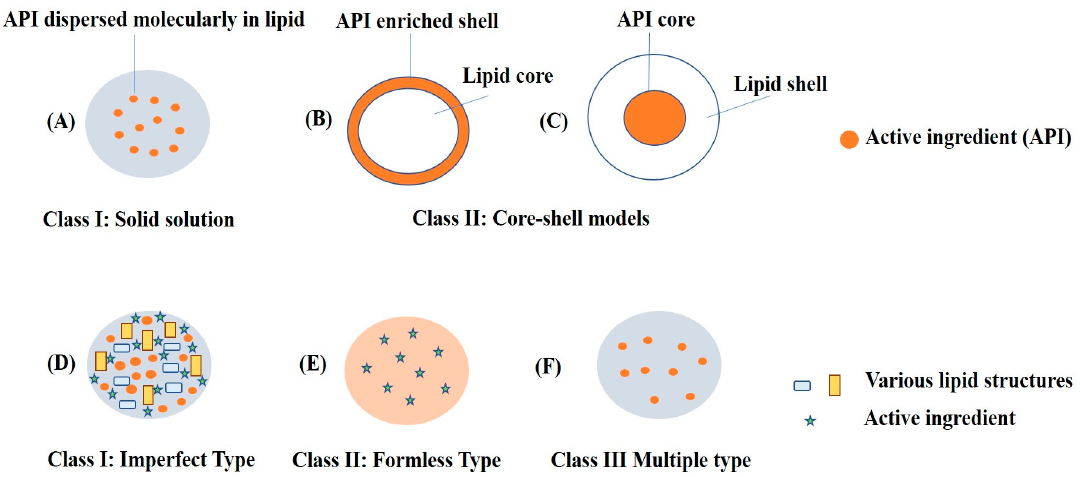
Figure 3. Schematic representation of SLNs: ( A ) solid solution model; ( B ) core-shell model (drug- enriched shell); and ( C ) core-shell model (lipid-enriched shell) and NLCs: ( D ) imperfect type of drug encapsulated in a gap between fatty acid chain of solid and liquid lipids; ( E ) formless-type mixture of solid and liquid lipids preventing crystal formation; ( F ) multiple-type nanocompartments of oils containing dissolved drug.